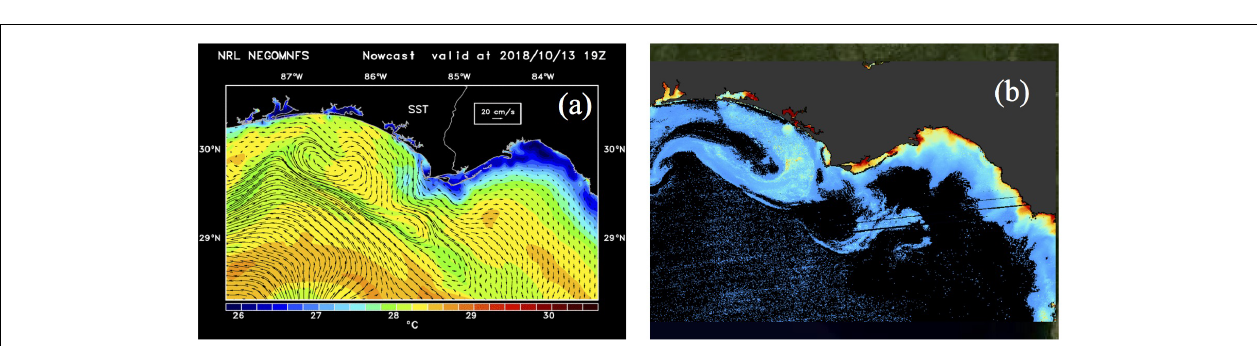
FIGURE 8 | Fluxes of DOC and POC from Apalachicola Bay. Hourly and de-tided fluxes (kg s − 1 ) of DOC (A,B) and POC (C,D) integrated through the all bay passes (positive – out of the bay and negative into the bay) between October 5 and 21, 2018.